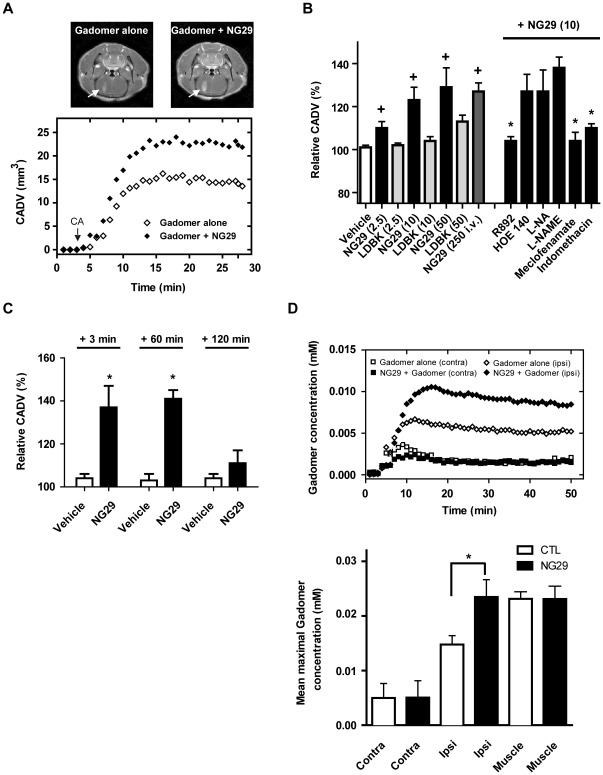
NG29 increases transvascular delivery, distribution and accumulation of Gadomer within brain tumor tissues of F98-bearing rats.(A) Representative axial Gadomer-enhanced T
1-weighted MR images depicting the brain of an F98-implanted rat before and after intracarotid NG29 treatment (10 nmol/kg/min for 5 min i.c.) (upper panels). Note the increase of the signal intensity at the tumor (white arrows). CADV in function of time calculated from the corresponding set of images (1 image/51 s for 50 min) (bottom panel). (B) Dose-, B1R-, PGs-dependence of NG29-induced BTB permeability. Numbers in parenthesis represent infusion rates in nmol/kg/min, for 5 min. The B2R antagonist HOE140 and the B1R antagonist R892 (both at 20 nmol/kg/min, for 5 min, i.c.) were infused simultaneously with NG29 while the non-selective nitric oxide synthase (NOS) inhibitors L-NA (5 mg/kg, i.v.) and L-NAME (20 mg/kg, i.v.), and the non-selective cyclooxygenase (COX) inhibitors Meclofenamate (5 mg/kg, i.v.) and Indomethacin (2.5 mg/kg, i.v.) were administered 30 min before the infusion of NG29. Note the effectiveness of NG29 administered by the i.v. (intrajugular) route. +p<0.05 compared to vehicle-treated animals; *p<0.05 compared to NG29 (10 nmol/kg/min)-treated animals. (C) Duration of the increase in BTB permeability caused by NG29 as detemined by relative CADV values. Gadomer was injected 3 min, 60 or 120 min following the start of the infusion (10 nmol/kg/min) of NG29 over 5 min. Each bar represents the mean ± S.E.M. for 3 to 7 animals. *p<0.05 compared to respective vehicle-treated animals. (D) Representative time course of Gadomer uptake in the ipsilateral (tumor-implanted) hemisphere and the contralateral hemisphere, before and after treatment with NG29 (10 nmol/kg/min for 5 min) (left panel). Histographic representation of average maximal Gadomer concentrations in the ipsilateral (tumor-implanted) and the contralateral hemispheres, and the facial muscle following NG29 treatment (right panel). As observed for Gd-DTPA, levels of Gadomer were higher in the ipsi- (tumors) than in contralateral (normal) tissues in CTL animals (not illustrated, ***p<0.001). *p<0.05 compared to untreated (Gadomer alone) ipsilateral groups. Value represents the mean ± S.E.M. obtained from 3 animals.